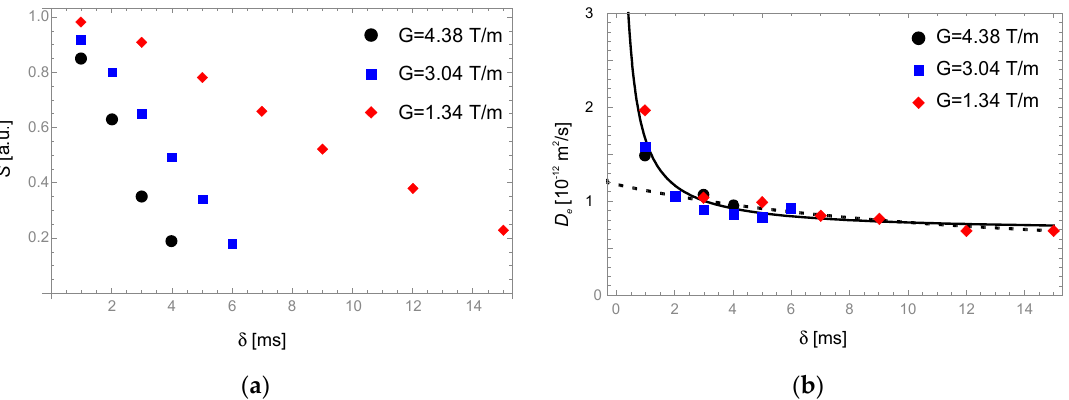
Figure 2. Measurements of polyethylene melt self-diffusion with the PGSE and a fixed diffusion time Δ = 80 ms at temperature 426 K: ( a ) The echo amplitude as a function of the applied gradient pulse width for different applied gradient strengths; ( b ) The effective diffusion coefficient as a function of the applied gradient pulse width. Included are the least-square fits of the model in Equation (9) with the best-fit parameters for all the data (solid line) and excluding the shortest δ points (dashed line).